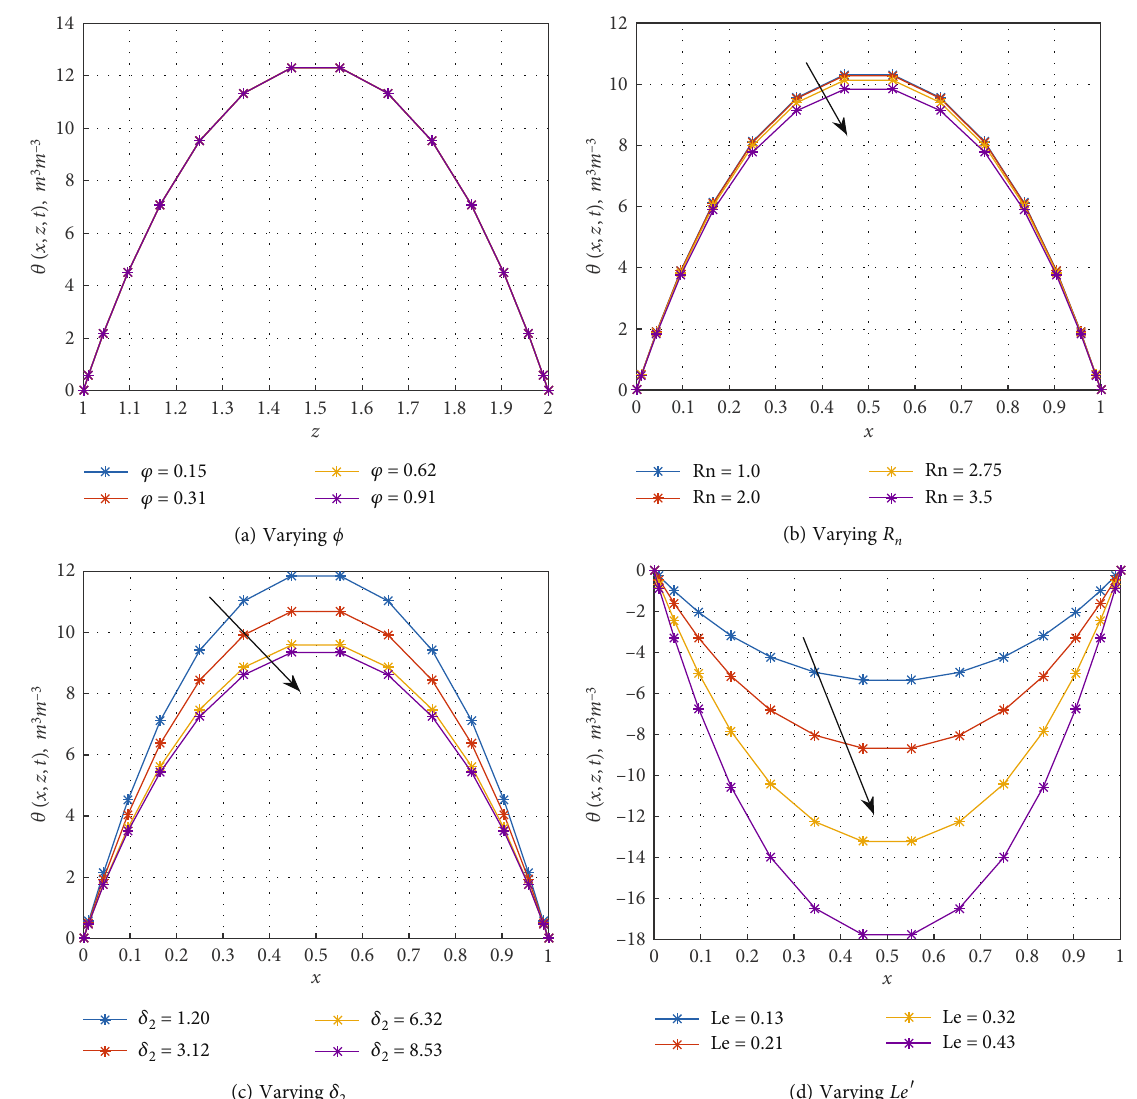
Figure 10: E ff ect of ϕ , R